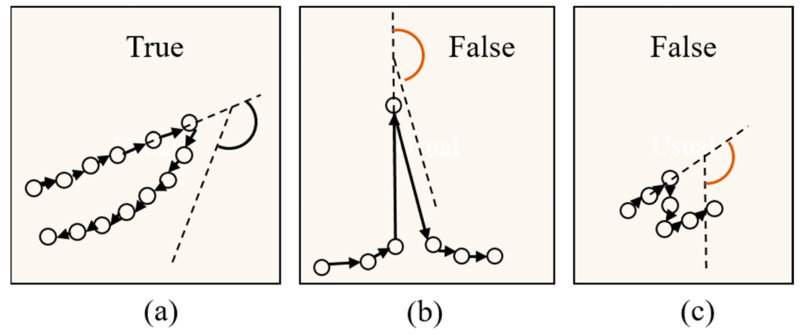
Figure 3. Several cases of large-angle changes in the heading angle. ( a ) correct large-angle change, ( b ) false large-angle change that is caused by noise, and ( c ) false large-angle change that is caused by a short